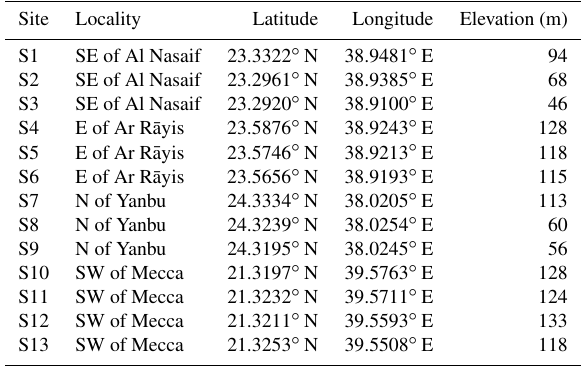
Table 1. Localities of soil sampling sites along the Red Sea coastal